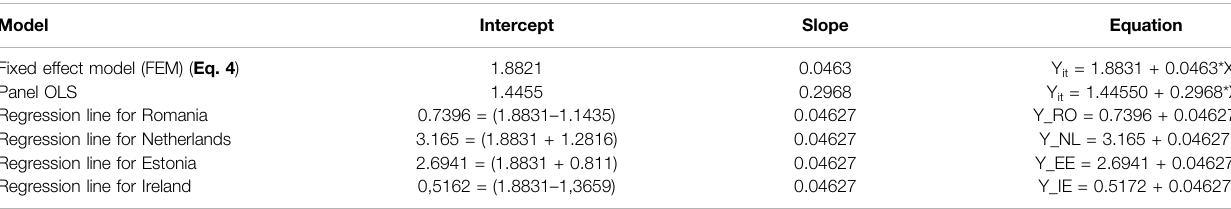
TABLE 7 | Equations of the FEM model and for some countries ( Figure 5 ). Model